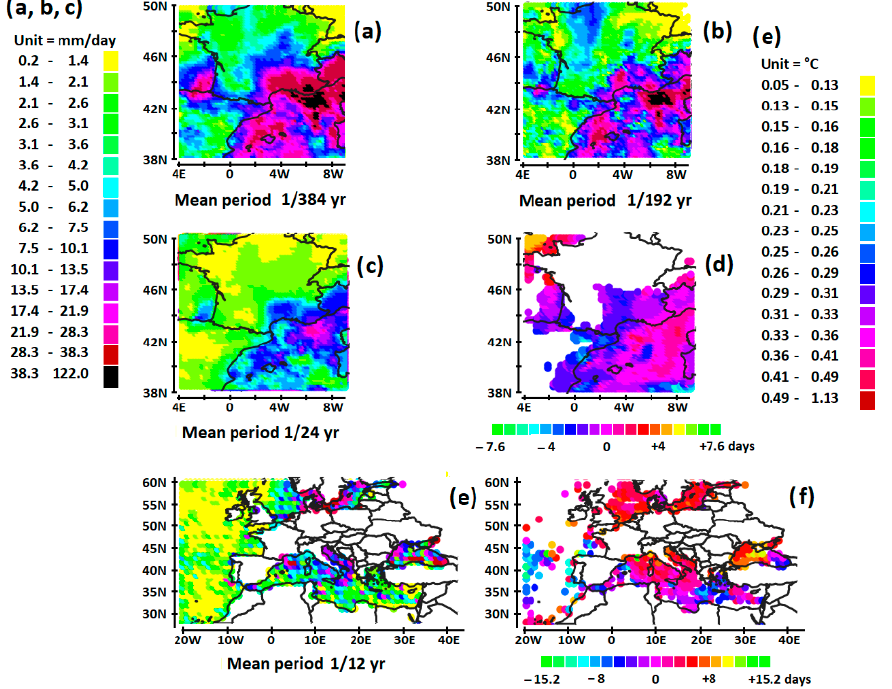
Figure 15. Extreme rainfall in France. Same conventions as in Figure 7. Time lags in ( d , f ) are expressed in relation to 4 November 2011. The time reference is the rainfall depth at 42° N, 4° E. Co-Evolution of SST and Rainfall Anomalies in Characteristic Period Ranges Clustering of mesoscale lows occurs in tune with the 1/24 harmonic, resulting in a compact cyclonic system in the Mediterranean Sea off the southeastern coast of France (Figure 15c,d). SST anomalies greater than 0.4 ◦ C are located in the central part of the Mediterranean Sea, the Adriatic Sea, but also, in the north, the Baltic Sea as well as the North Sea South of the Scandinavian countries (Figure 15e,f). They are concomitant with the 1/12 harmonic. On the other hand, the Atlantic Ocean is absolutely not involved in the formation of the low-pressure system. The peak of the SST anomalies is 4 days behind the occurrence of the ERE over